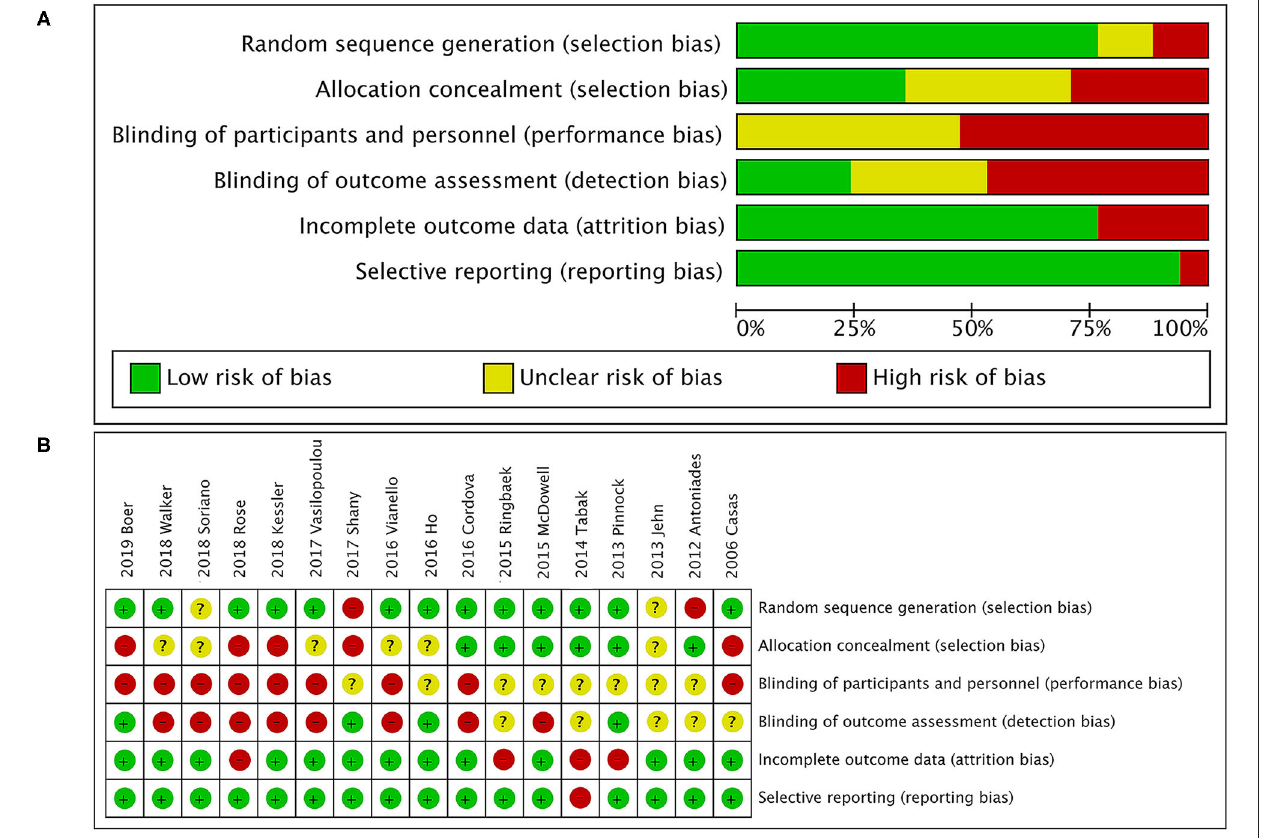
FIGURE 2 | Quality assessment. (A) Risk of bias graph; (B) risk of bias summary. The overall risk of bias in randomized controlled trials (RCTs) was rated as moderate to high for issues related to blinding. Owing to the type of intervention, patients and health care research team could not be blinded for group assignment, as it